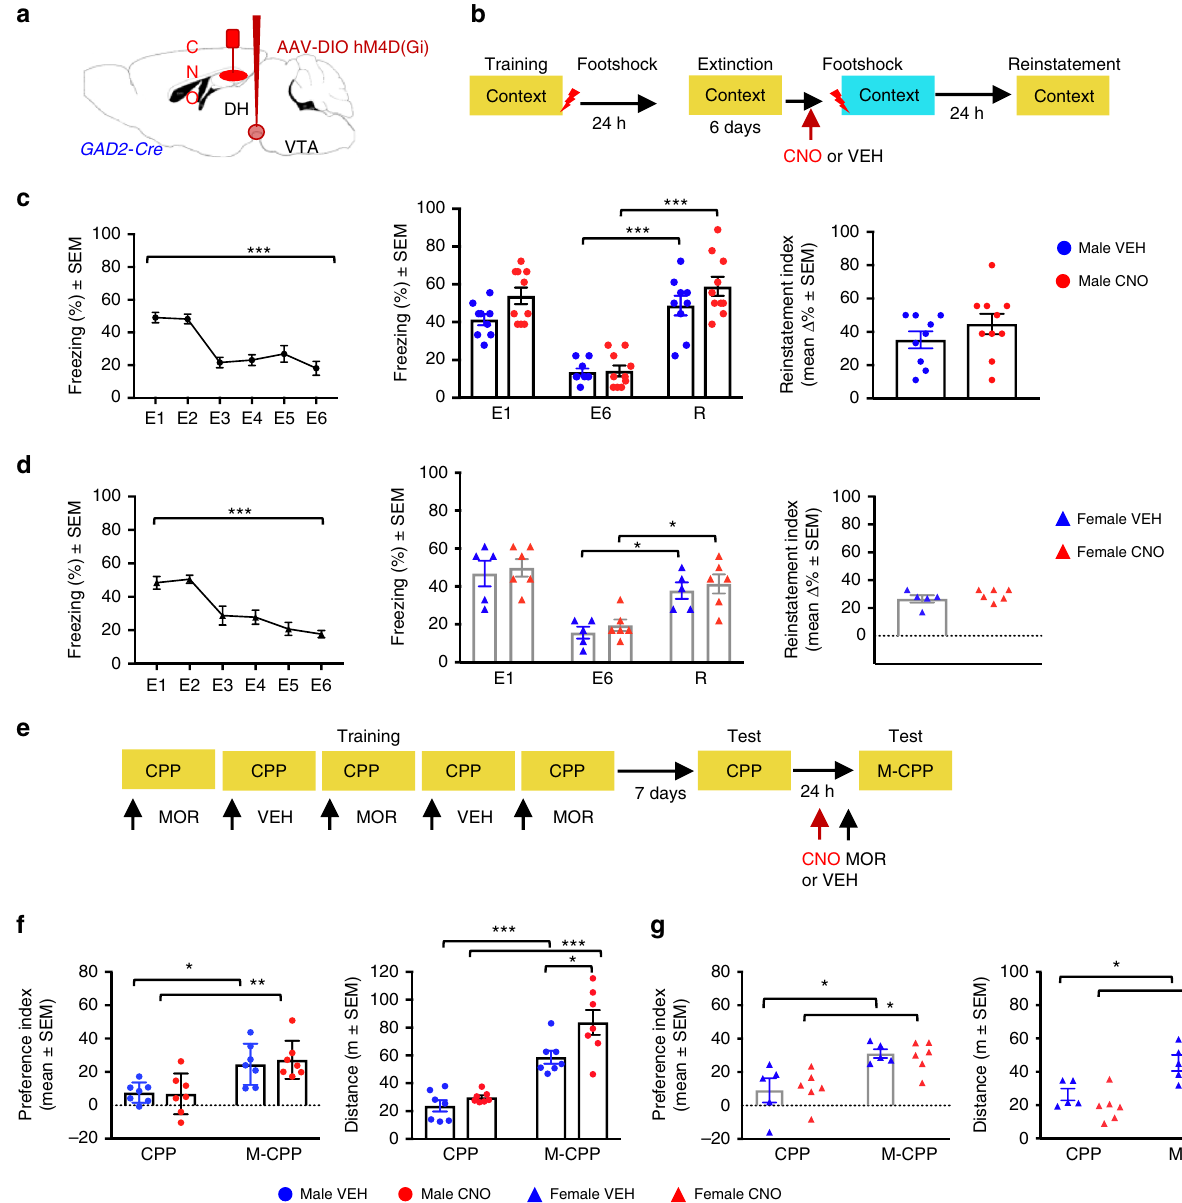
Fig. 6 Silencing VTA → DH neurons in male and female GAD2-Cre did not affect fear reinstatement or M-CPP. a Virus infusion into VTA and cannulation in DH. b Fear reinstatement procedure. c Left, extinction in GAD2-Cre males [RM one-way ANOVA, F (3.049, 54.88) = 18.5, P < 0.0001]. Middle, reinstatement of freezing behavior in VEH ( n = 9, *** P < 0.0001) and CNO ( n = 10, *** P < 0.0001) groups without treatment × test interaction [two-way ANOVA, F (2, 51) = 1.259, P = 0.2925]. Right, CNO did not affect the fear reinstatement index (right, two-tailed unpaired t test, t 17 = 1.178, P =